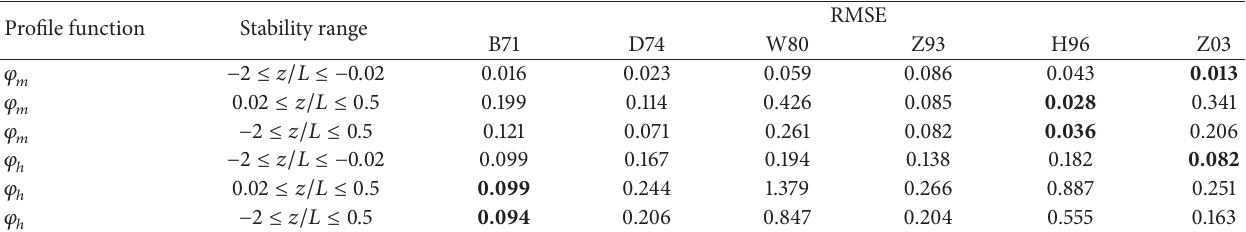
Figure 5: (a) Observed and calculated nondimensional wind profile function 𝜑 𝑚 against 𝑧/𝐿 . The solid lines are obtained from (8a). (b) As (a), but for 𝜑 ℎ , the solid lines are obtained from (8b). Table 4: The RMSE using our revised 𝜑 𝑚 and 𝜑 ℎ compared to six typical ones a